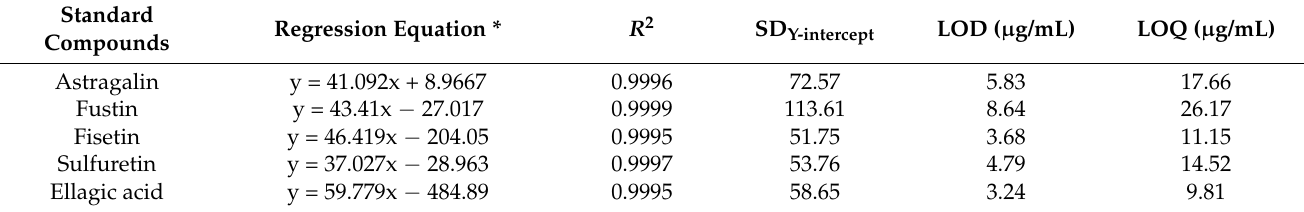
Table 1. The UPLC analyzed regression data, LODs, and LOQs for the marker compounds (n = 3).